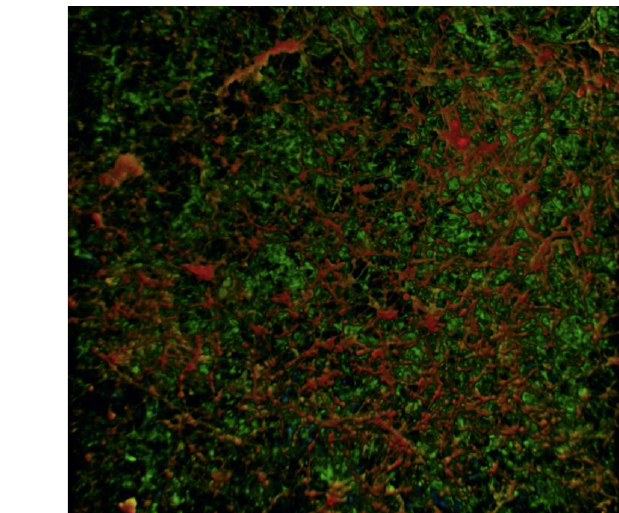
Figure 3. Microscopy images at 4× magnification of well-plate grown biofilms using crystal violet staining under different treatment conditions showing the ( a ) untreated biofilm control, ( b ) mechan- ically shred biofilm immediately after high-energy (0.55 mJ/mm 2 ) EM shockwave treatment, ( c ) Amp-B-treated biofilm after 12 h, and ( d ) combination of Amp B + medium energy (0.19 mJ/mm 2 ) EH shockwave treatment after 12 h.